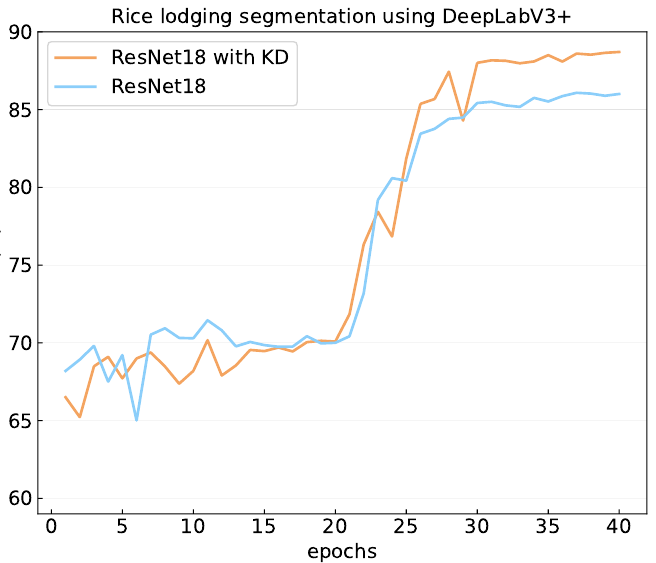
Figure 7. Performance of channel-wise knowledge distillation. Note that ResNet18 is the backbone network of